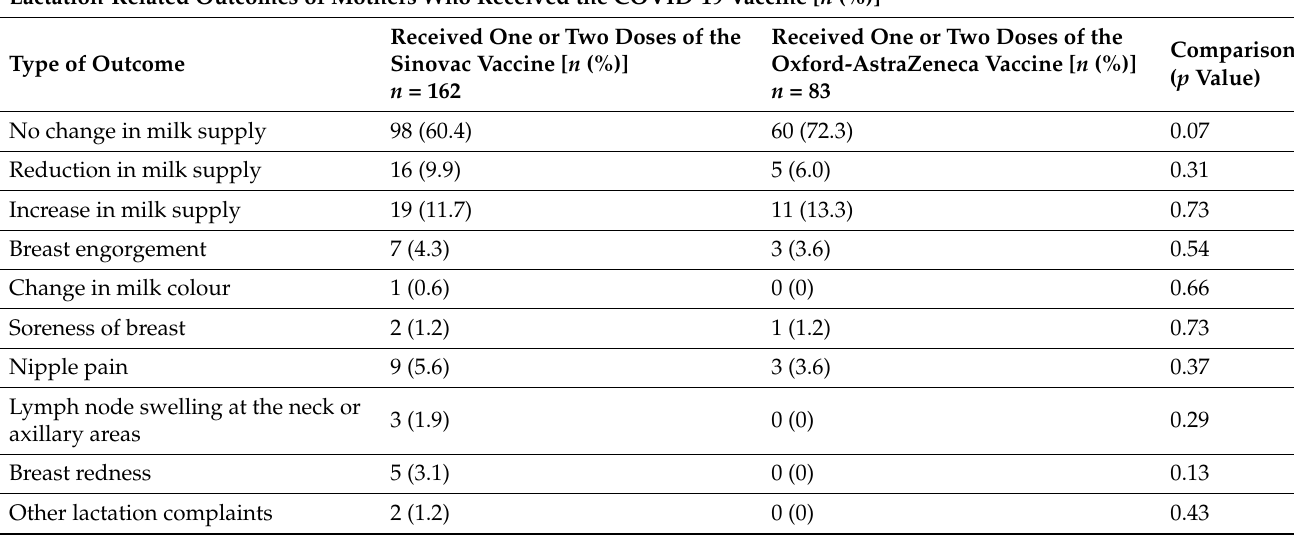
Table 3. Maternal–child outcomes of respondents who received non-mRNA